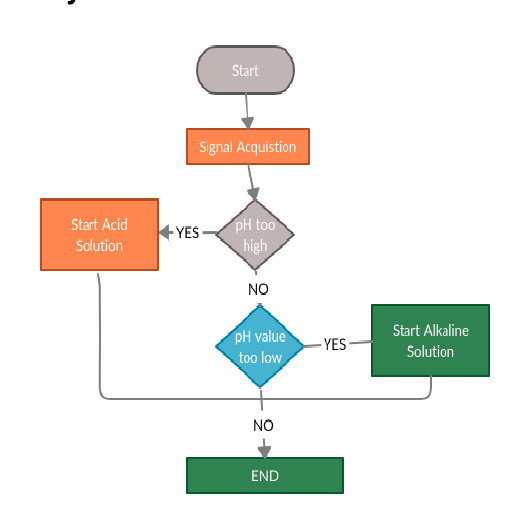
Fig. 6. Proposed System